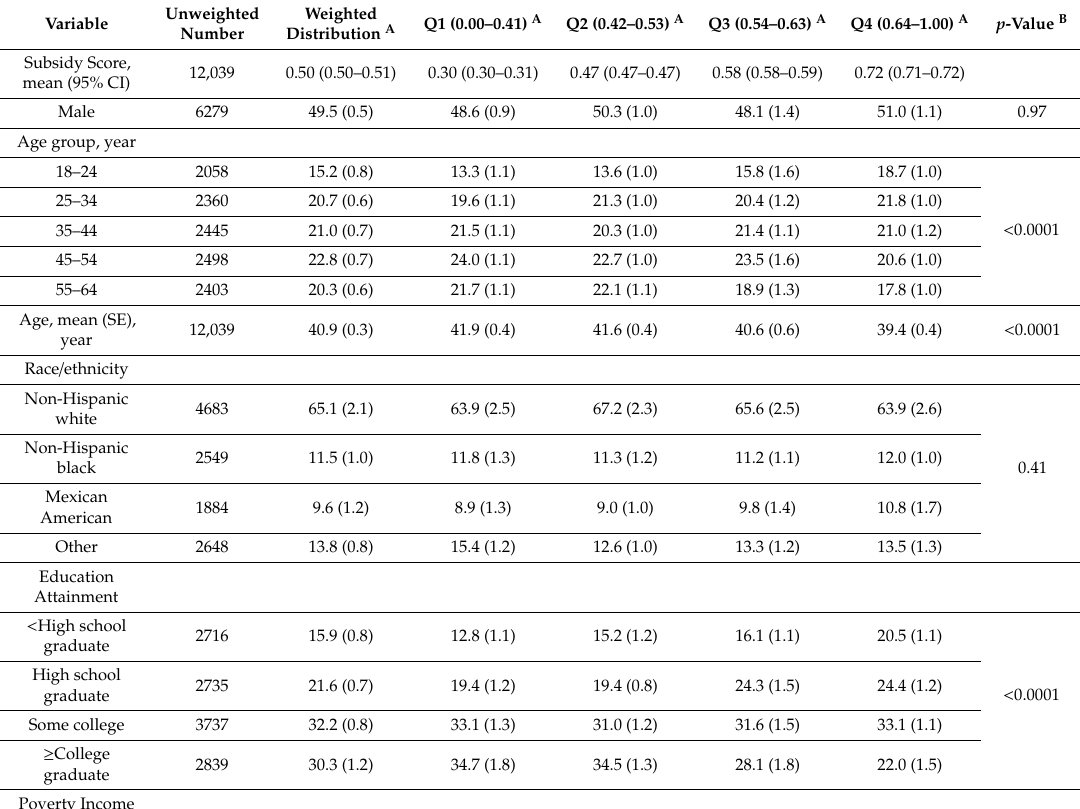
Table 1. Characteristics of US adults aged 18 to 64 years in the National Health and Nutrition Examination Survey from 2009–2014 overall and by subsidy score